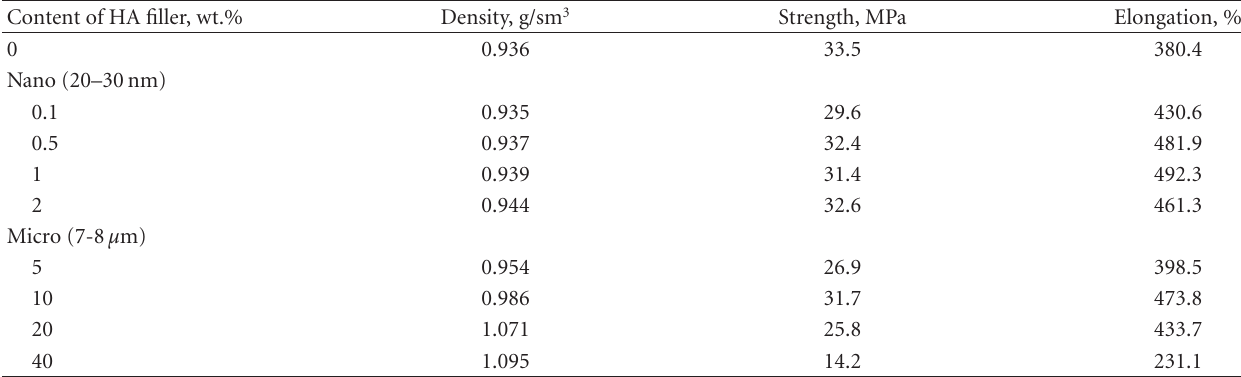
Table 1: Mechanical properties of nano- and microcomposites based on UHMWPE. Content of HA filler,